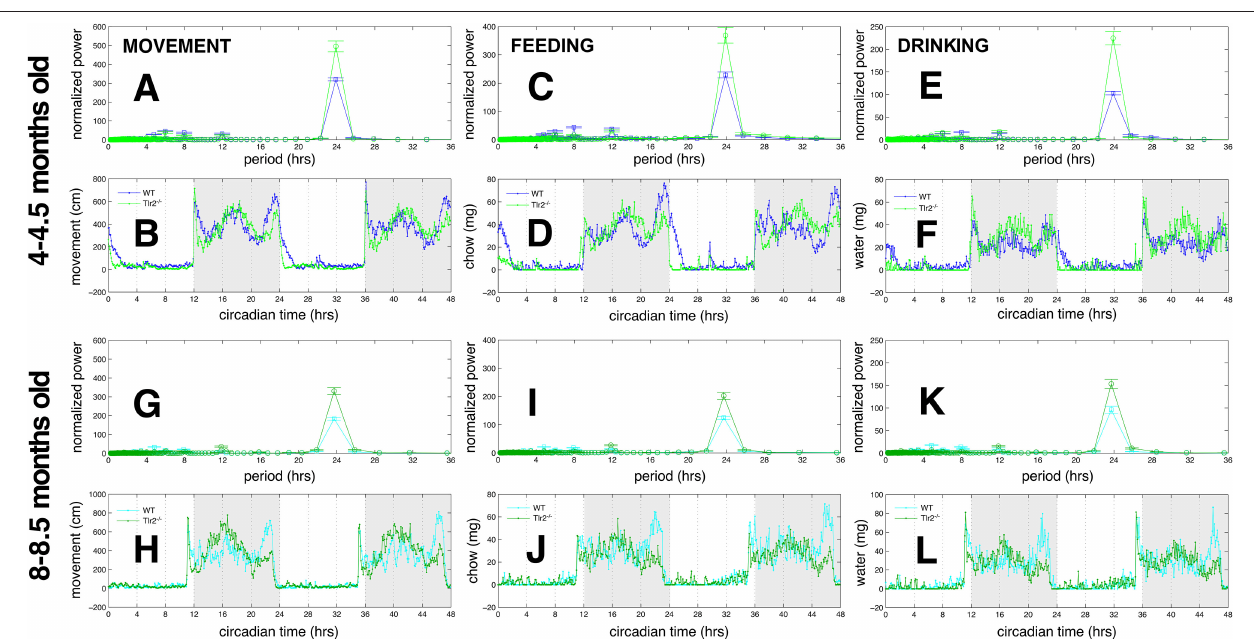
FIGURE 6 | Tlr2 − / − mice have stronger 24-h periodicities compared to WT mice (A) . Lomb-Scargle periodogram for movement, 4–4.5 months old mice. WT periodogram in blue, Tlr2 − / − periodogram in green (B) . Observed movement for WT (blue) and Tlr2 − / − (green) cohorts, 4–4.5 months old mice. Thin line with points depicts the mean values for each cohort (C) . Lomb-Scargle periodogram for feeding. 4–4.5 months old mice. WT in blue, Tlr2 − / − in green (D) . Observed feeding for WT (blue) and Tlr2 − / − (green) cohorts. 4–4.5 months old mice. (E) Lomb-Scargle periodogram for drinking. 4–4.5 months old mice. WT in blue, Tlr2 − / − in green (F) . Observed drinking for WT (blue) and Tlr2 − / − (green) cohorts. 4–4.5 months old mice. (G) Lomb-Scargle periodogram for movement, 8–8.5 months old mice. WT periodogram in cyan, Tlr2 − / − periodogram in dark green (H) . Observed movement for WT (cyan) and Tlr2 − / − (dark green) cohorts. 8–8.5 month old mice. Thin line with points depicts the mean values for each cohort (I) . Lomb-Scargle periodogram for feeding. 8–8.5 months old mice. WT in cyan, Tlr2 − / − in dark green (J) . Observed feeding for WT (cyan) and Tlr2 − / − (dark green) cohorts. 8–8.5 months old mice (K) . Lomb-Scargle periodogram for drinking. 8–8.5 months old mice. WT in cyan, Tlr2 − / − in dark green (L) . Observed drinking for WT (cyan) and Tlr2 − / − (dark green) cohorts. 8–8.5 months old mice. For (A , C , E , G , I , K) error bars are ± 1 standard deviation. No significant periodicities of longer than 24 h obtained for any behaviors.